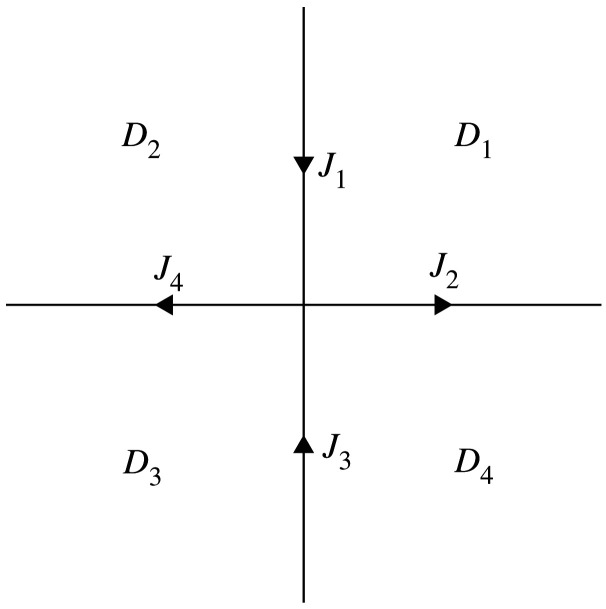
The four open quadrants D1, …, D4, the contour Σ=R∪iR, and the jump matrices J1, …, J4 defined in (2.14).